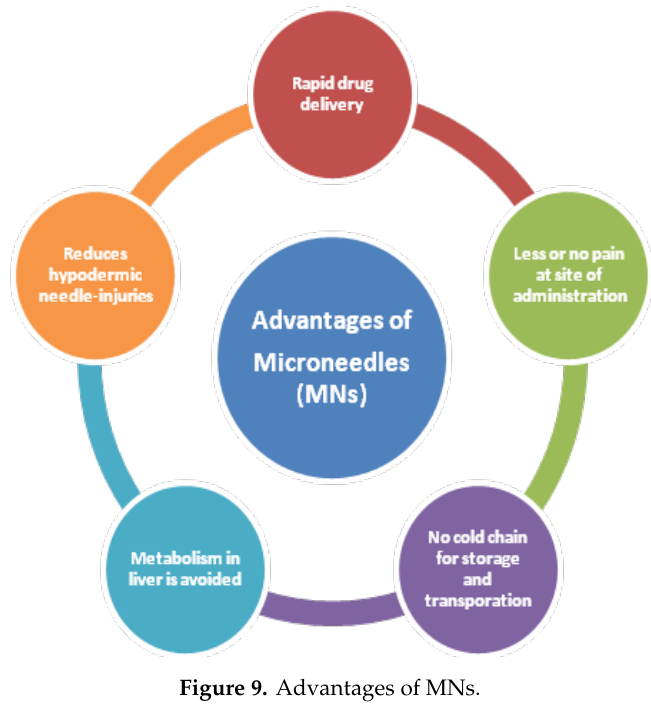
Figure 9. Advantages of MNs.